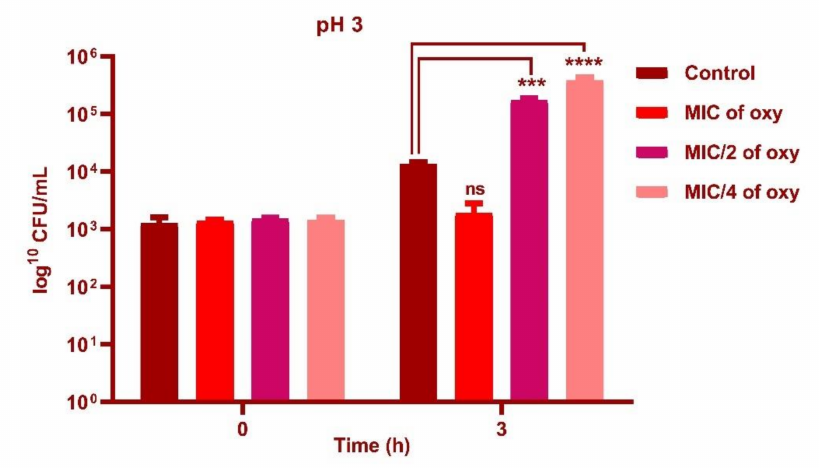
Figure 5. Viable counts (log CFU/mL) of L. fermentum ASBT-2 after 3 h of exposure to pH 2.0 with MIC, MIC/2 and MIC/4 concentrations of oxyresveratrol. **** Significantly different ( p ≤ 0.0001), * Significantly different ( p ≤ 0.05).